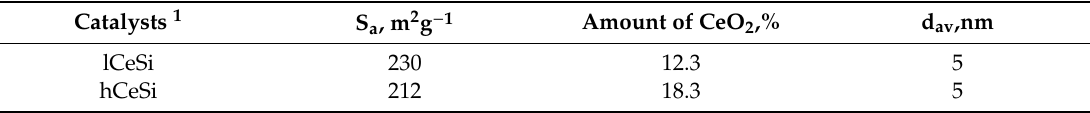
Table 5. Characteristics of CeO 2 / SiO 2 catalysts: specific surface area, amount and crystal size of CeO 2 . Catalysts